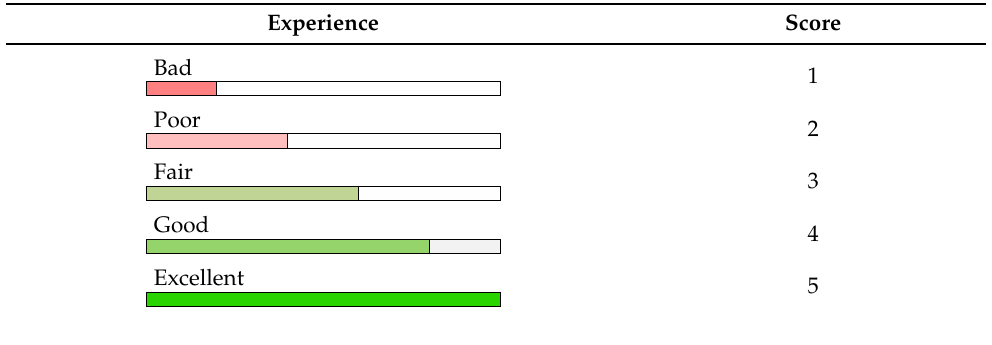
Table 11. Subjective mean opinion score evaluation.